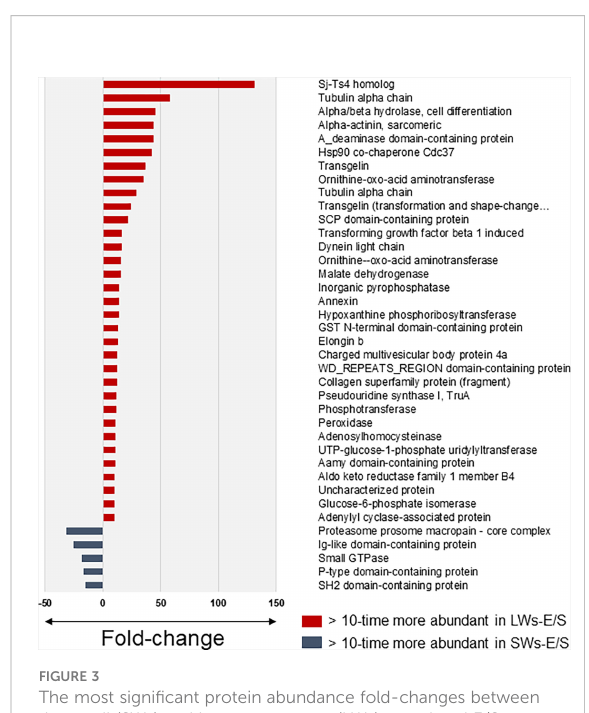
FIGURE 3 The most signi fi cant protein abundance fold-changes between the small (SWs) and large tapeworms (LWs) associated E/S proteins at three-hour time point in vitro . The log10 transformed LFQ data was analyzed using Student ’ s t-test with permutation- based FDR